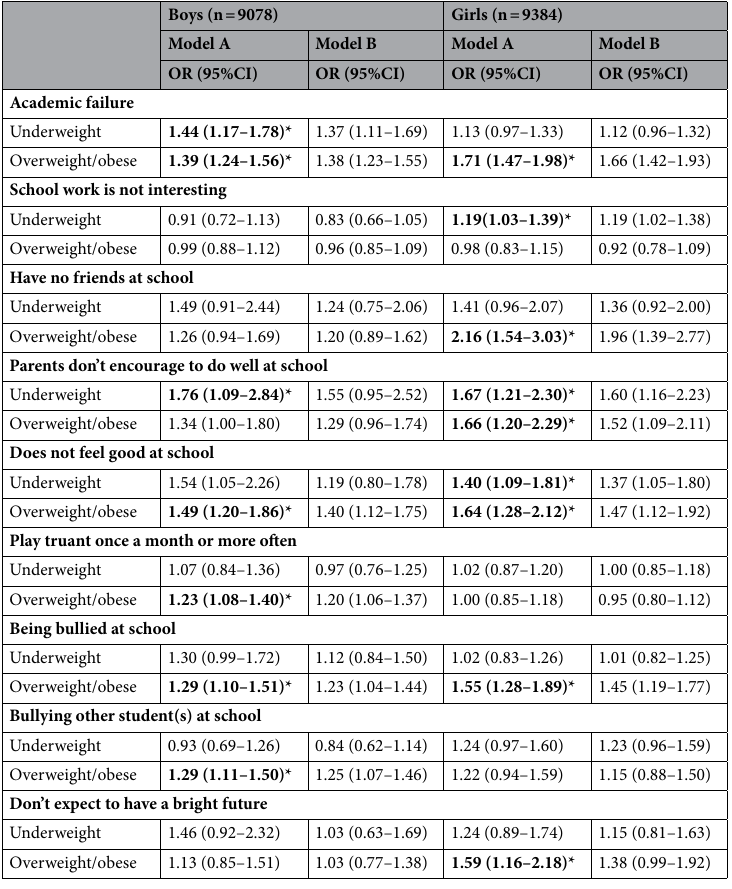
Table 4. Associations between weight status and school-related complaints among boys and girls. Normal weight is used as reference category. Model A: Controlled for adolescent’s age, parents’ ethnic background, family household structure, parents’ employment status, school location, and year of survey. Model B = Model A + psychosomatic complaints index. *Associations passed a critical P value corresponding to FDR of 0.05 (Model A